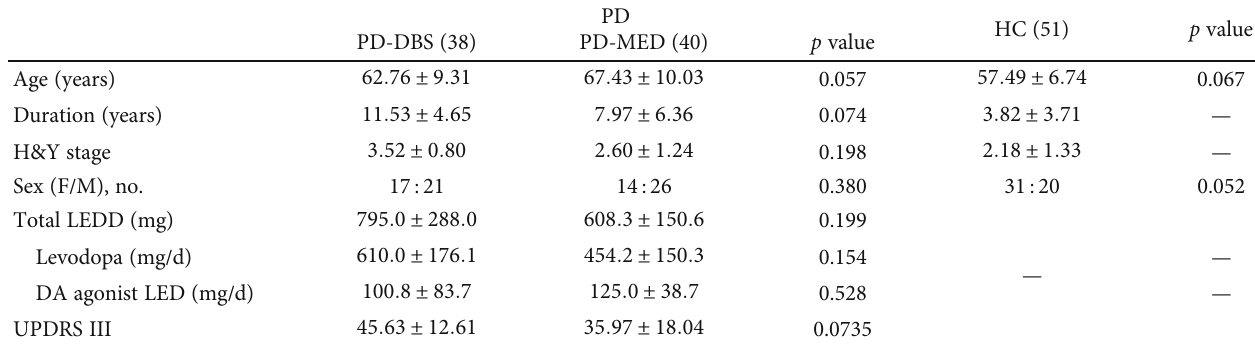
Table 1: Demographics and clinical feathers in all subjects.